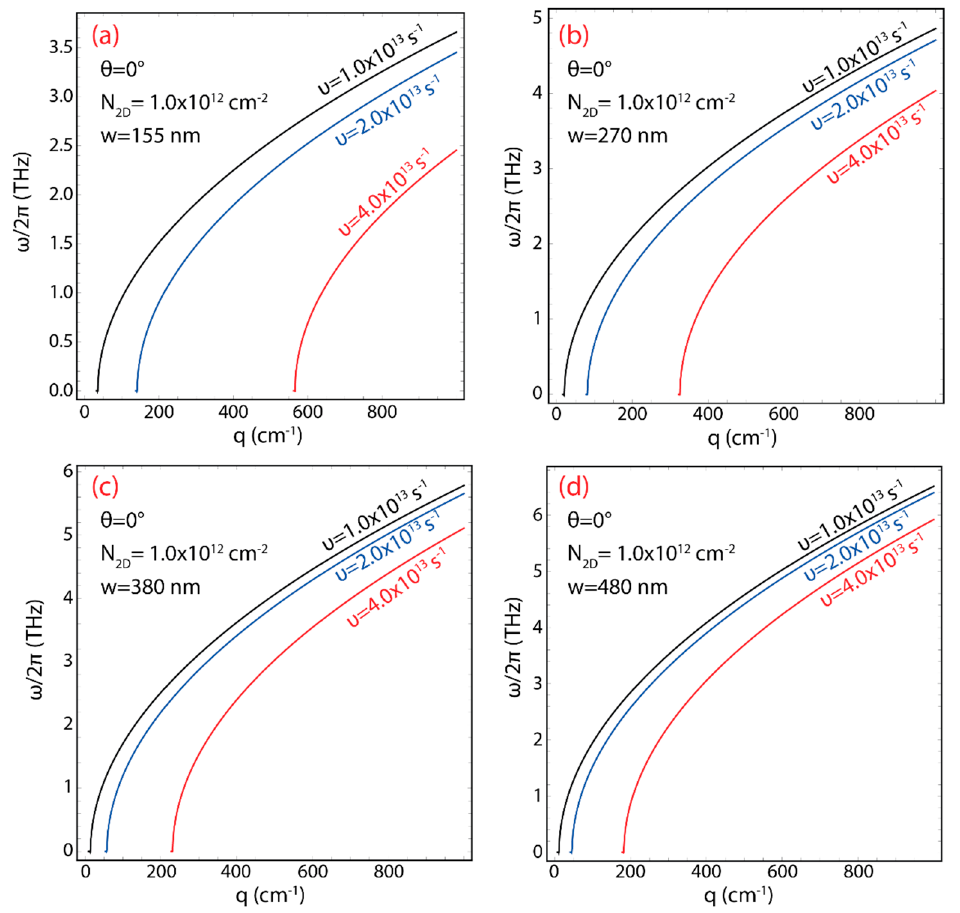
Figure 10. Plasmon frequency dispersion ( ω /2 π ) vs. wave vector ( q ) (using θ = 0, N 2 D = 1.0 × 10 12 cm − 2 , and v F = 0.829 × 10 6 m s − 1 ) for different values of electron relaxation rate ( ν = 1.0 × 10 13 , 2.0 × 10 13 , 4.0 × 10 13 s − 1 ) and different ribbon widths: ( a ) w = 155 nm, ( b ) w = 270 nm, ( c ) w = 380 nm, and ( d ) w = 480